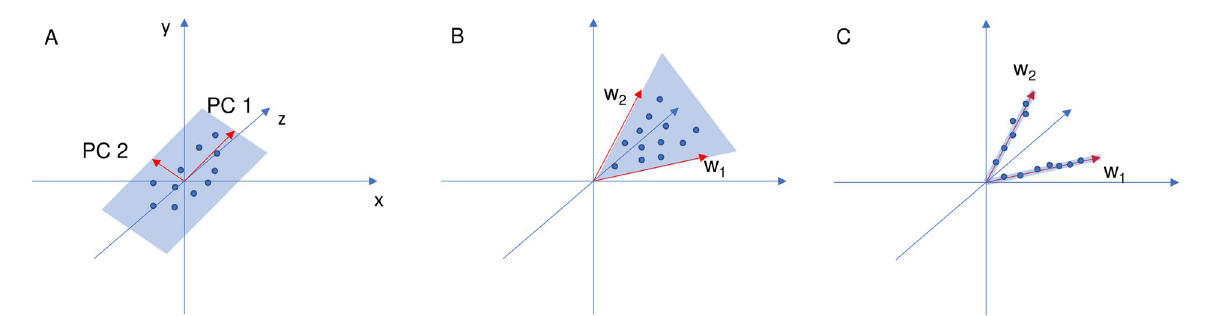
Fig 4. Graphical illustration of PCA(A), NMF(B), and sparse NMF(C). The matrix factorizations are reduced from three to two dimensions. PCA covers the solutions with a hyperplane, NMF constraints them between two vectors, and sparse NMF forces the solutions to be in the vicinity to the